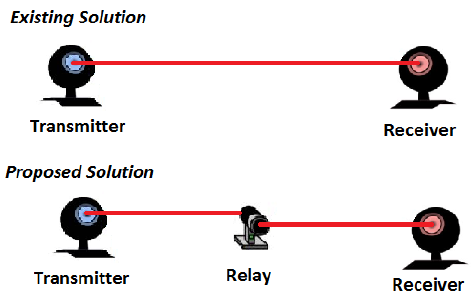
Figure 1. Synoptic diagram of the proposed blind detection free-space optical (FSO) system.